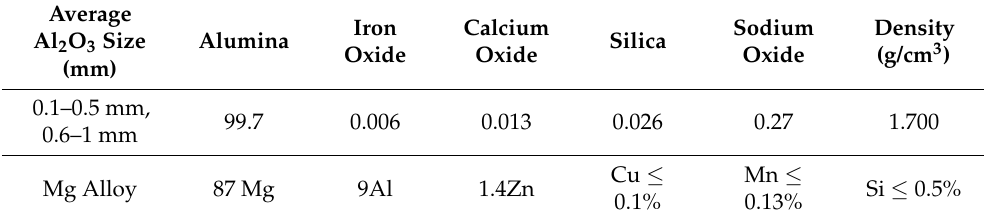
Table 1. Material